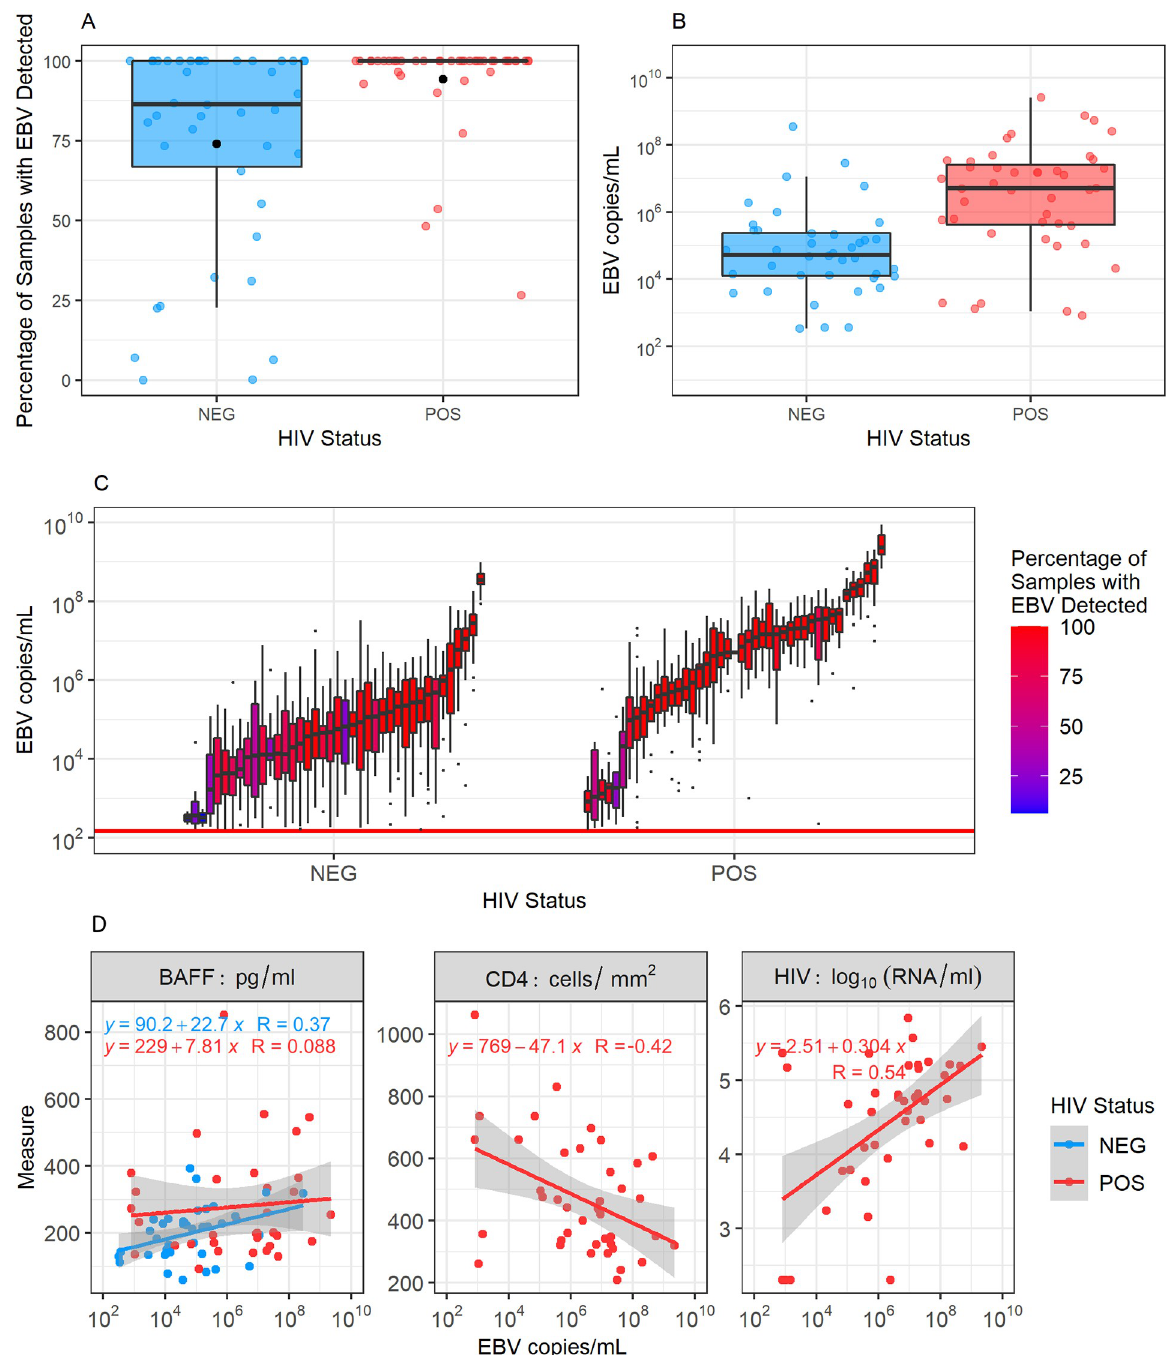
Fig 2. Impact of HIV-1 coinfection on oral EBV replication. A. Percentages of saliva samples that tested positive for EBV for each participant. Black dots indicate the percentage of samples that tested positive for EBV when pooling participant samples. In HIV-1 uninfected participants, the median percentage of swabs positive for EBV was 86% (range 0–100%, interquartile range (IQR) 33%), while in HIV-1 coinfected participants, the median percentage of swabs positive for EBV was 100% (range 27–100%, IQR 0%). B. Median EBV viral loads/ml in oral swabs testing positive for EBV for each participant. All graphs stratify participants by HIV-1 infection status. Coloured dots show the median value of the statistic for each participant, while bars and whiskers show the spread across participants. C. Distributions of participants’ oral swab viral loads. Each box and whisker represents the viral loads of EBV-positive oral swabs for an individual participant. The percentage of oral swabs that tested positive for EBV for each participant is indicated by the colour of the box. Of swabs that tested positive for EBV, viral loads varied over time by a median of 3.49 orders of magnitude (range 0.34–5.27, IQR 1.32) within individual HIV-1 uninfected participants and a median of 2.30 orders of magnitude (range 0.95–5.93, IQR 1.15) within individual HIV-1 coinfected participants. The red horizontal line represents the threshold of EBV detection (150 EBV copies/ml). D. Participants’ BAFF levels, CD4+ T cell counts, and HIV-1 RNA loads correlated against median EBV copies/ml of saliva.